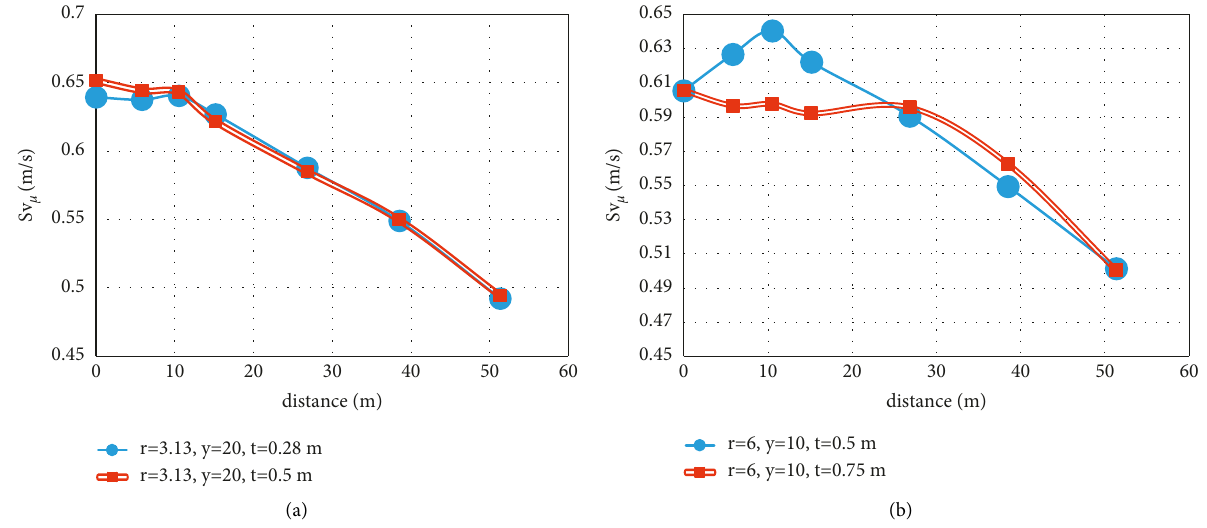
r=3.13, y=20, t=0.28 m r=3.13, y=20, t=0.5 Figure 18: The effect of change in tunnel lining thickness on ground surface velocity for models (a) 20 and 21 and (b) 22 and 23 of Table